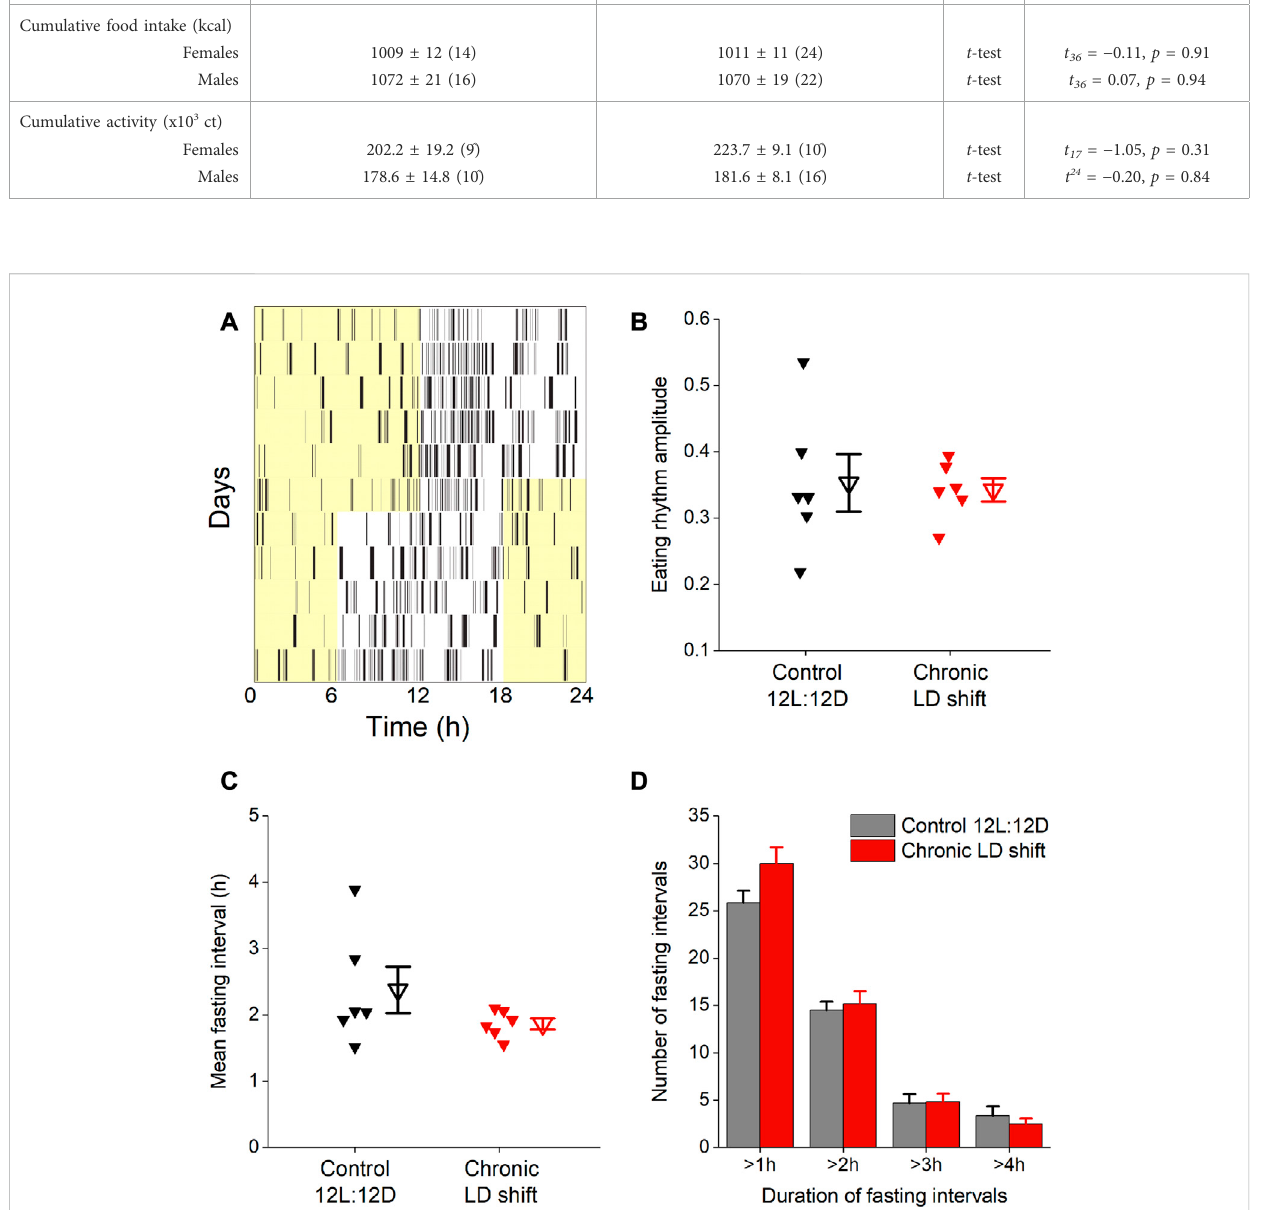
FIGURE 4 Chronic LD shifts did not affect eating behavior in female ApoE − / − mice. Eating behavior was measured with infrared video cameras during control 12L:12DandwhentheLDcyclewasadvanced6 h (A) .Theamplitudesofthedailyrhythmsofeatingbehavior (B) ,durationofdailyfastingintervals (C) ,and number of fasting intervals that were > 1 h, > 2 h, > 3 h, and > 4 h (D) were measured. b,c: individual mice are closed symbols and open symbols are mean ±